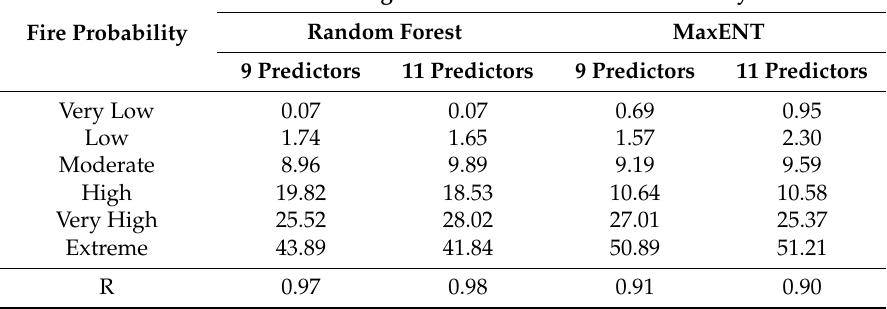
Table 3. Comparison of the di ff erent types of long-term wildfire presence probability modeling methods in Yakutia (macroscale).